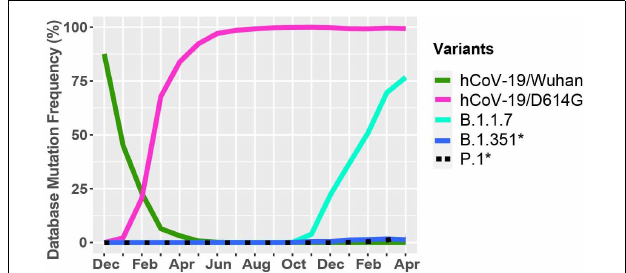
FIGURE 4 | Worldwide frequency of B.1.1.7, B.1.351, P.1 and D614G variants. Database variants frequency were analyzed from December 2019 to April 30, 2021. hCoV-19/Wuhan is the original reference strain and hCoV-19/D614G is the current reference strain containing the D614G mutation in the S protein. B.1.1.7, B.1.351, and P.1 represent the United Kingdom, South African, and Brazilian variants. *Overlapping